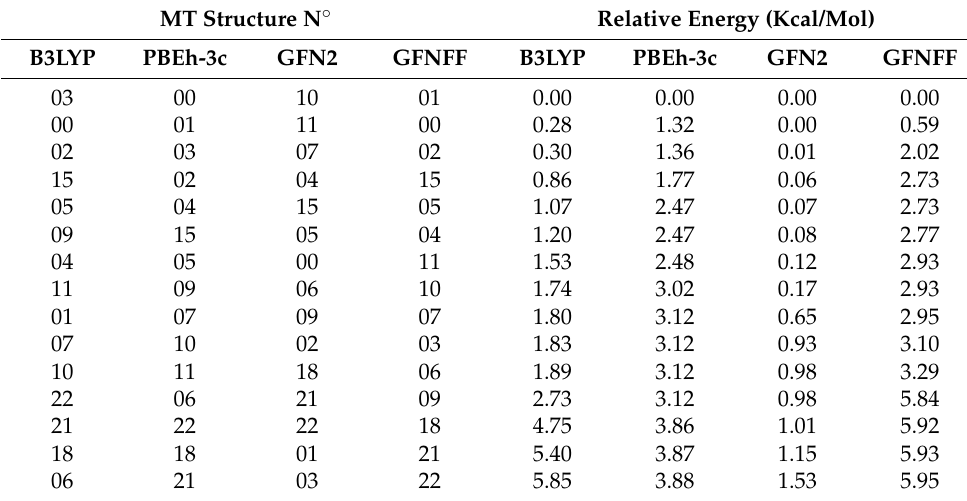
Figure 2. ( a – d ) Optimized low-energy minima of isolated gas phase melatonin (MT). In the notation MTXX, the number XX corresponds to the structure number according to the CCSD(T) ranking calculated by Fogueri et al. [47]. Atom colors: H white, C grey, N blue, O red. Table 1. Energetic ranking of the low-energy conformers of melatonin (MT). The numbers of MT structures correspond to the CCSD(T) ranking calculated by Fogueri et al. [47]. Values are in